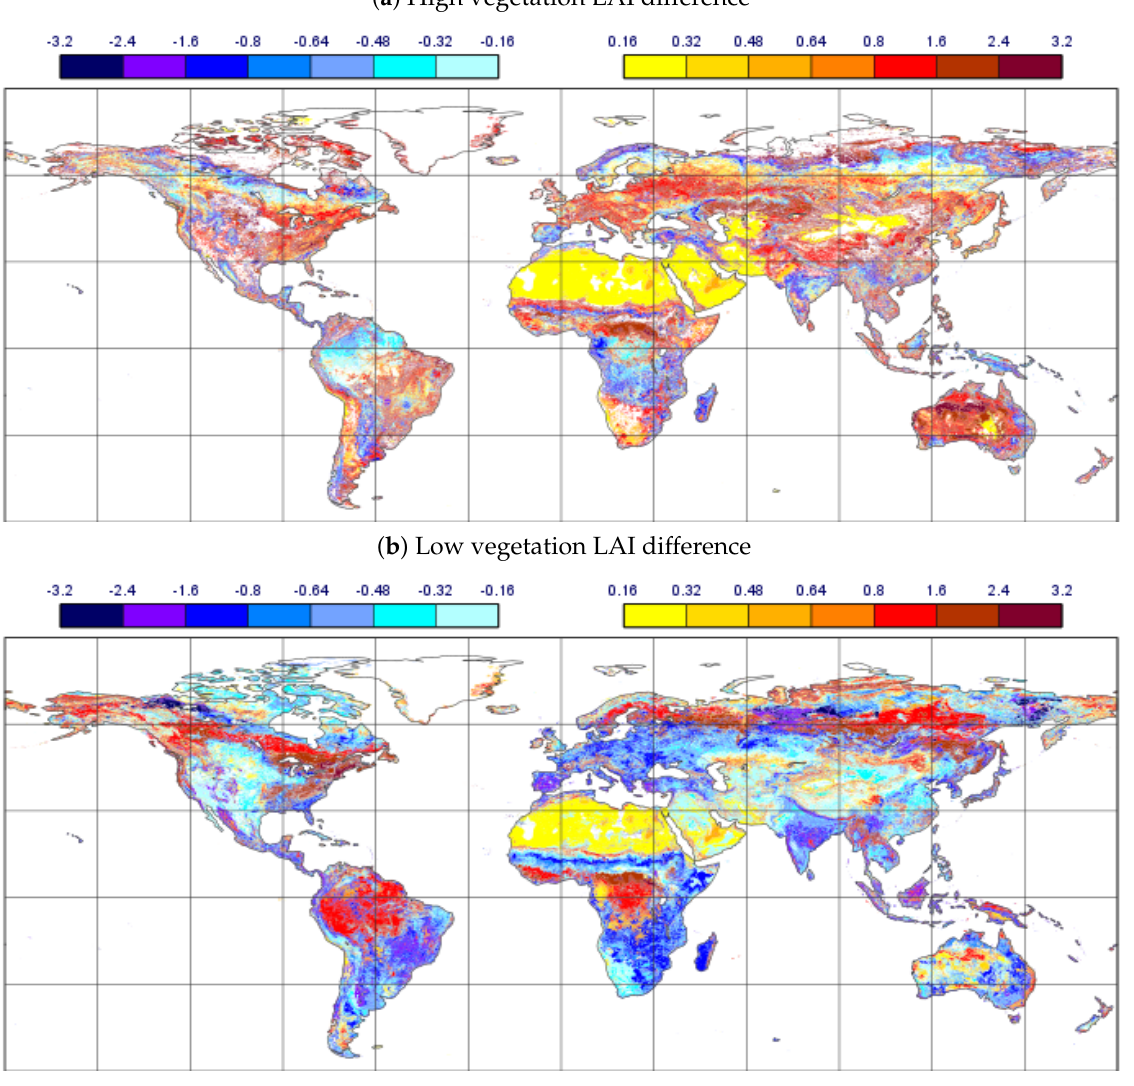
Figure 3. LAI differences for the month of July: Conservative disaggregation—Current: ( a ) for the high vegetation types (forest and trees); ( b ) for the low vegetation types (crops, grass and herbaceous